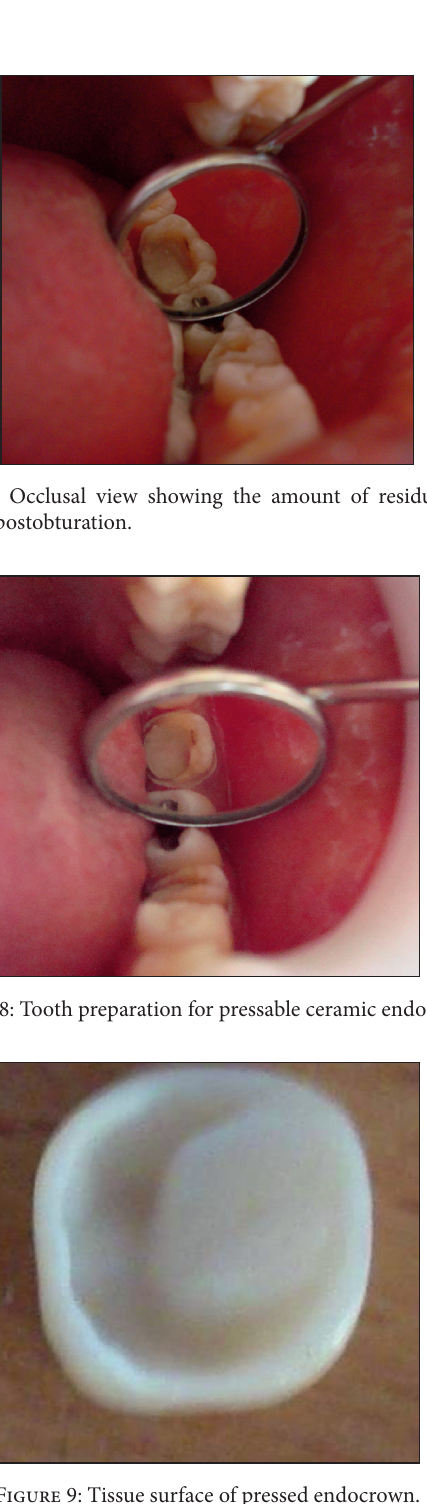
Figure 12: Radiographic view, postcementation. The supragingival finish line is clearly